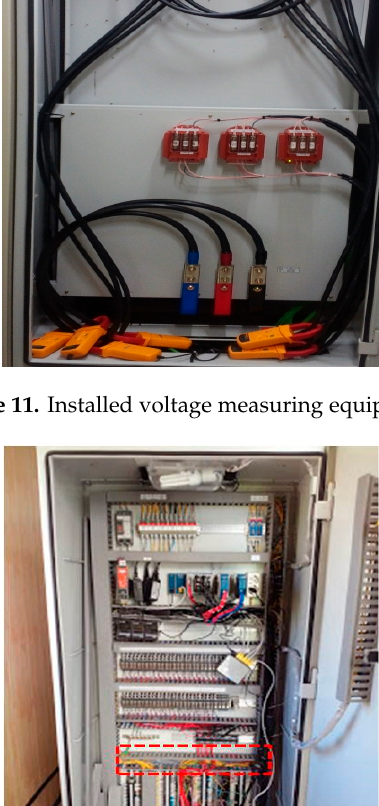
Figure 10. Monitoring system configuration for power quality analysis.